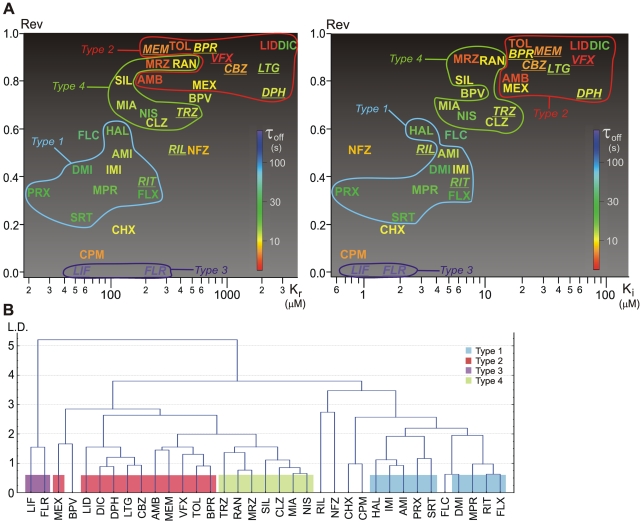
Localization of SCIs in the “biophysical space”.Clustering based on properties of inhibition. A) Distribution of the biophysical properties illustrated in a quasi-three-dimensional plot. Reversibility (Rev) values are plotted against Kr and Ki values, τoff is color coded on a logarithmic scale. Lack of use-dependence is indicated by underlined italic fonts. Drugs classified into different types of inhibition are circled. The position of overlapping codes were minimally (<5%) adjusted for visibility. For exact values see Table 2 and Table 3. B) Result of a cluster analysis based on seven properties of inhibition: log Kr, log Ki, log IC50, log SD, UD, Rev and log τoff. (Weighted pair group average method was used as amalgamation rule, with Euclidean distance measure.) L.D.: Linkage distance.